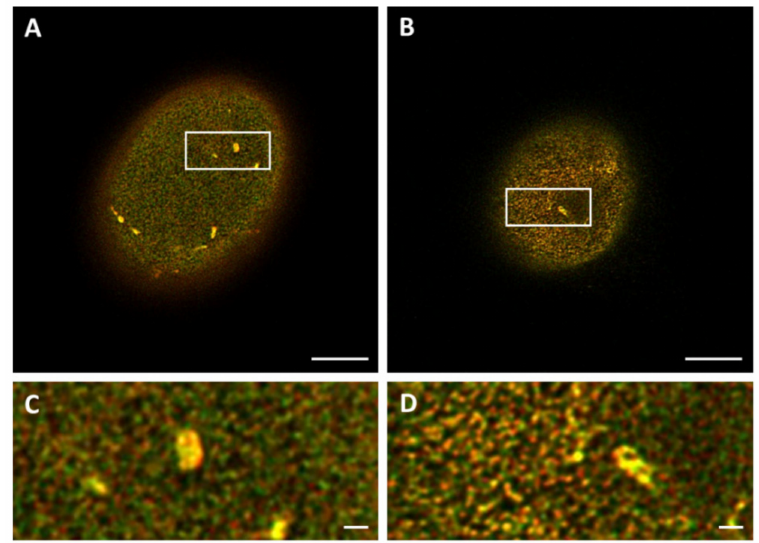
Figure 6. Merged STED microscopy images of the top of the nucleus, visualizing the lamin A (red) and lamin B1 (green) network. ( A ) 3T3 transfected with lamin-A-YFP/lamin-B1-EGFP. ( B ) 3T3 stained with antibodies against lamin A and B1. ( C , D ) Higher magnification (4.3x) of ROIs in ( A , B ). Scale bars: 5 µ m.